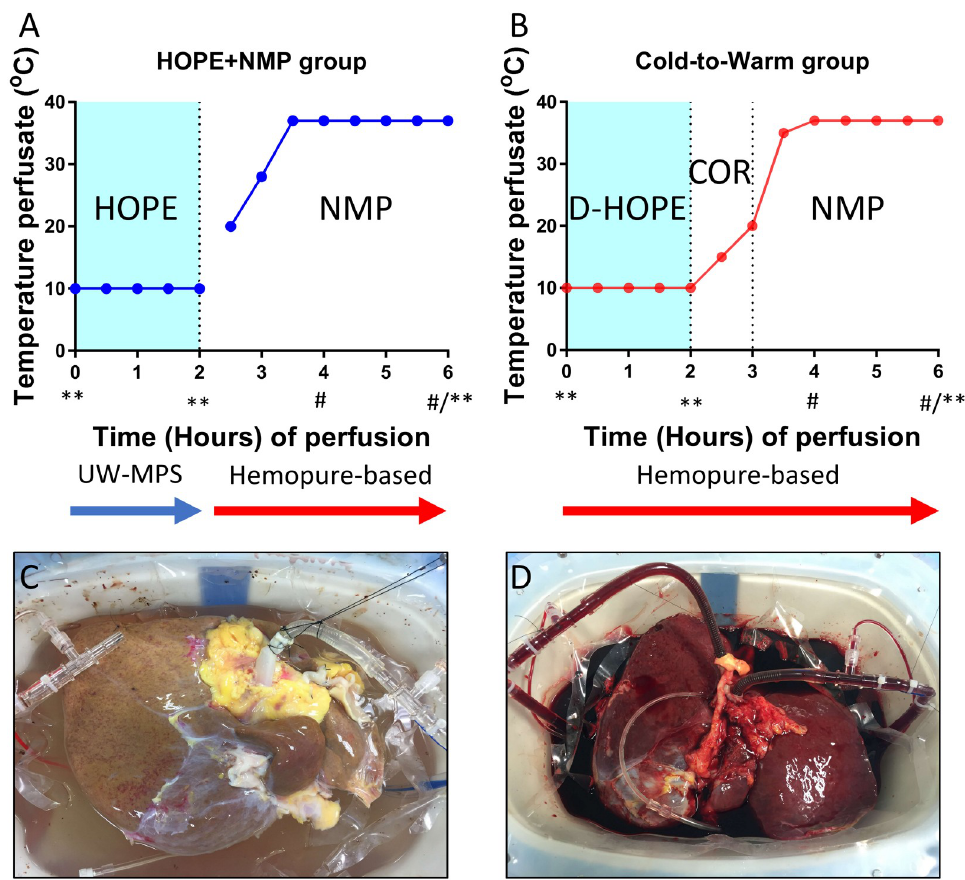
Fig 1. Study design. Donor human livers had standard procurement, they were cold flushed and stored. Once rejected for transplantation, they were offered for research and consecutively allocated to the two experimental groups. Image A shows the protocol for the HOPE+NMP group, livers had hypothermic oxygenated perfusion (HOPE) using Belzer MPS 1 UW Machine Perfusion Solution for 2 hours. HOPE was performed at 10 ˚C via the portal vein only, as represented on image C. After 2 hours, the perfusate was changed to an acellular haemoglobin-based oxygen carrier (HBOC) Hemopure 1 (HBOC-201, Hemoglobin 1 Oxygen Therapeutics LLC, Cambridge, USA)-based perfusate for the rewarming and normothermic machine perfusion (NMP). The livers from the cold-to-warm group (Image B) were fully cannulated at the start of the perfusion, including portal vein, hepatic artery and common bile duct (Image D). They received the HBOC-based perfusate from time 0. For this group, the livers had 2 hours of dual hypothermic oxygenated perfusion (D-HOPE) at 10 ˚C followed by 1 hour of slow rewarming to 20 ˚C (controlled oxygenated rewarming [COR]) and then NMP. Menghini and wedge biopsies were collected at time 0, 2 and 6 hours ( �� ) and immediately fixed in formalin or snap-frozen in liquid nitrogen. Blood gas analysis was carried out and perfusate was sampled at 30 min time intervals throughout. In addition, bile production was measured at time 4 and 6 hours (#) and analysed at 6